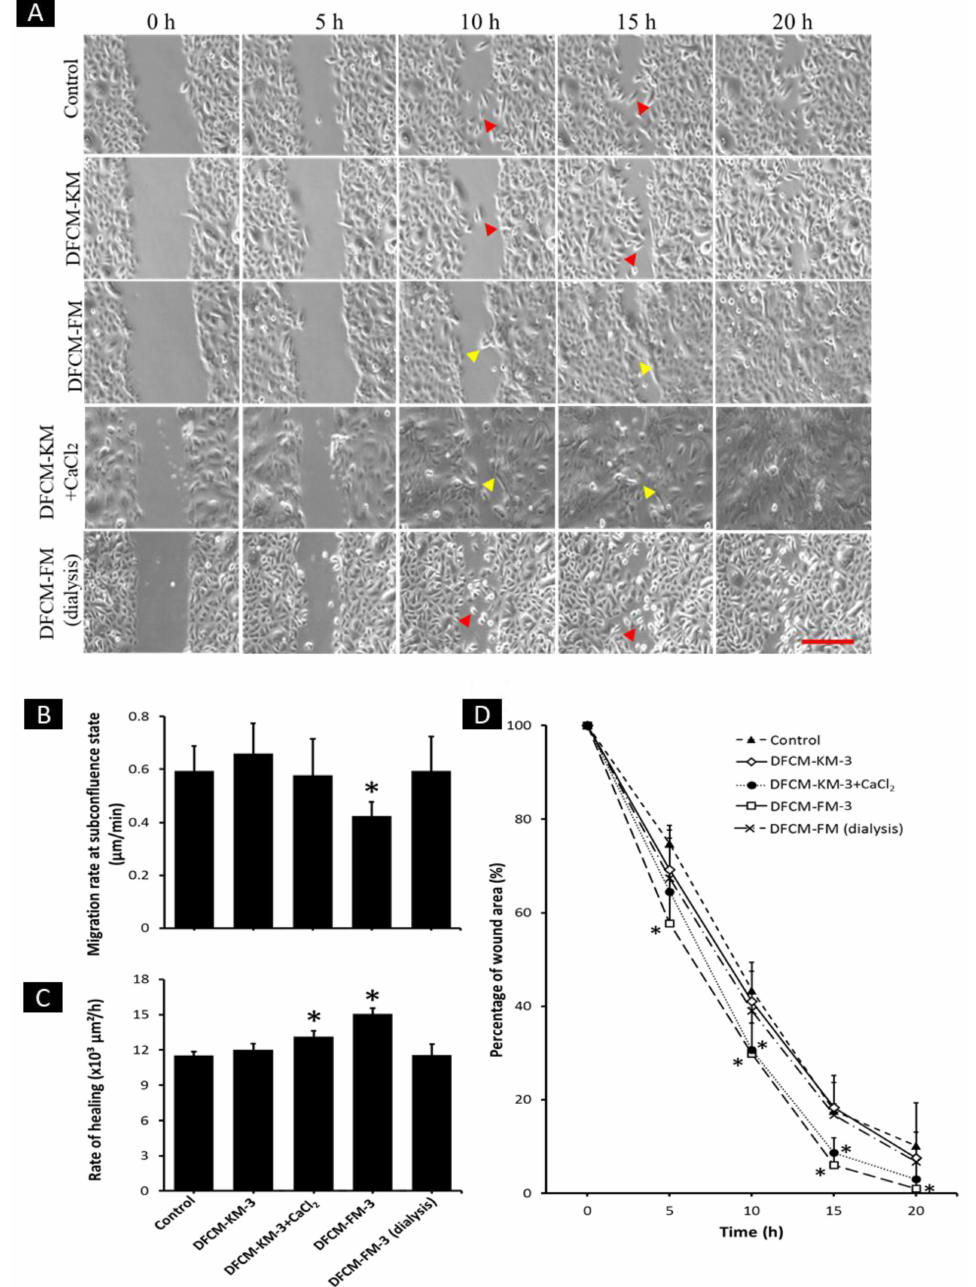
Figure 6. Effect of calcium in DFCM on keratinocyte migration under subconfluent and confluent condi- tions. ( A ) Representative image of keratinocyte migration during in vitro healing. Arrow